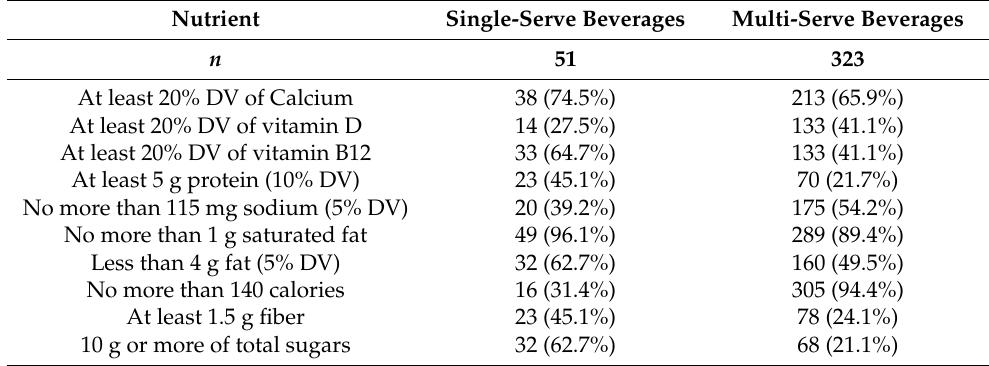
Table 3. Number (%) of non-dairy beverages meeting the suggested nutrient guideline per serving. Nutrient Single-Serve Beverages Multi-Serve